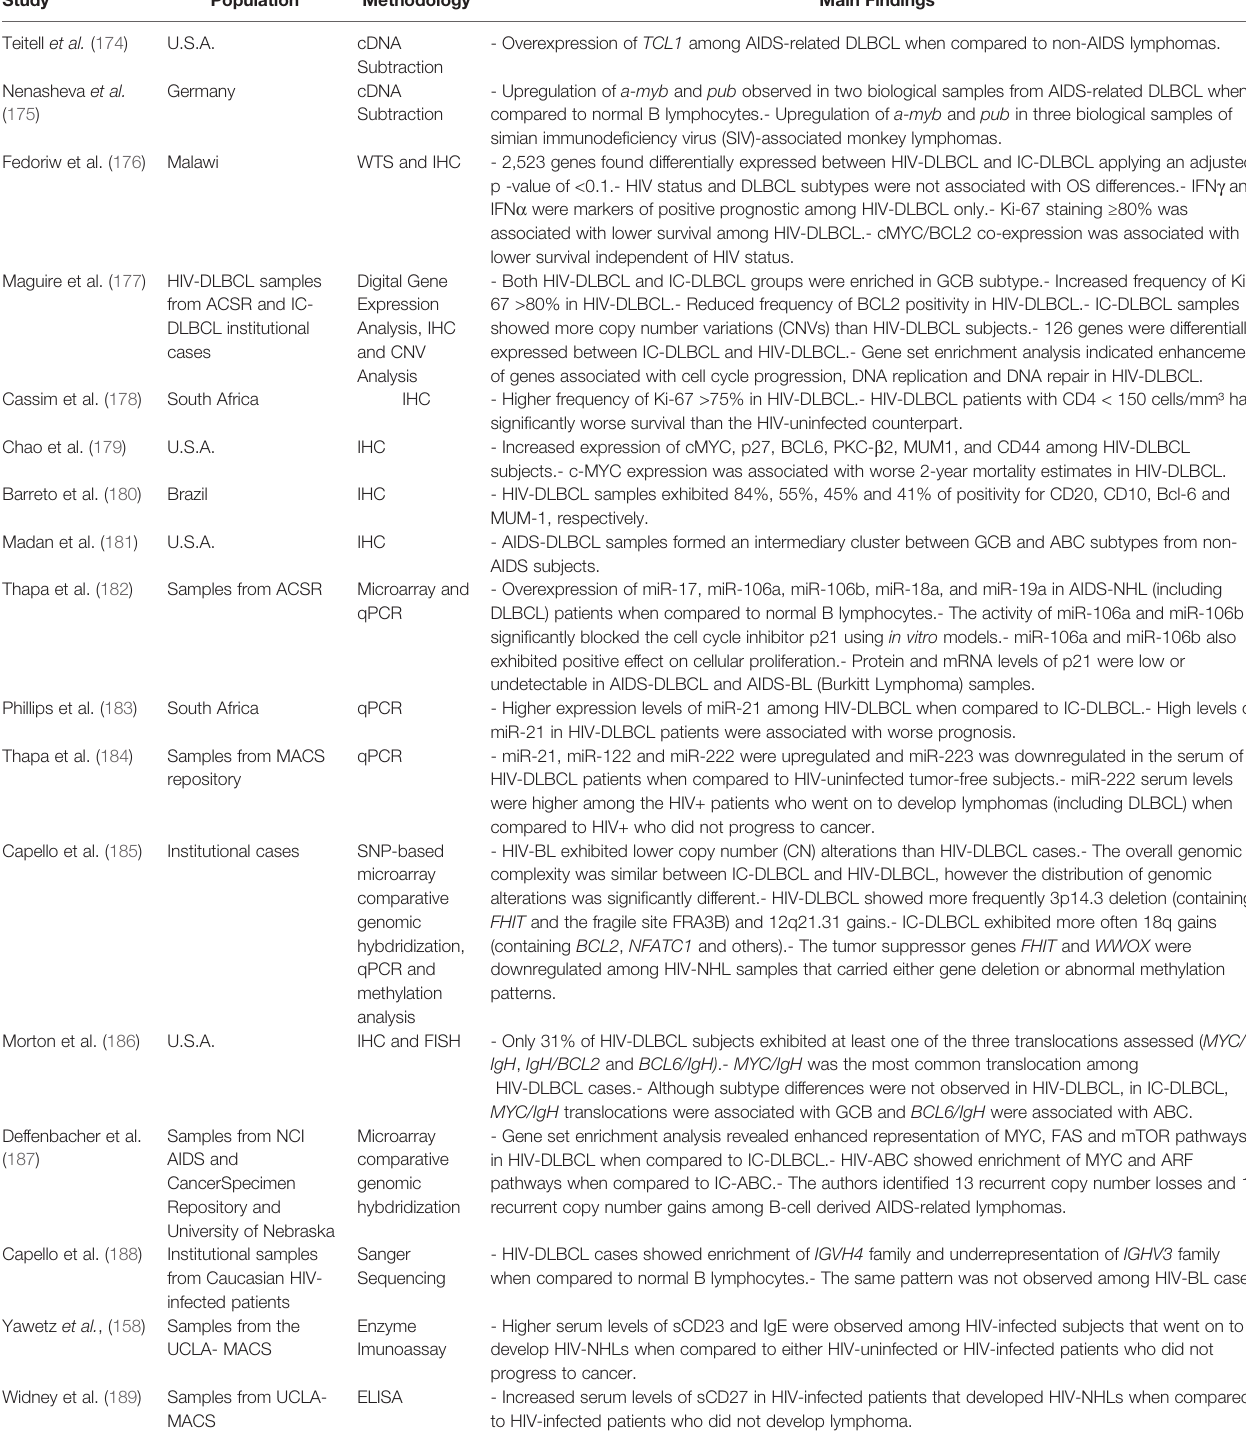
TABLE 1 | Highlights of reports that explored the molecular characteristics of